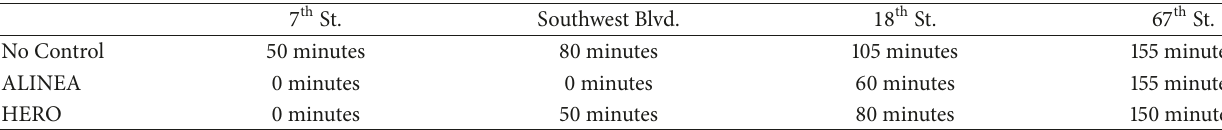
Table 7: Congestion duration for the three control